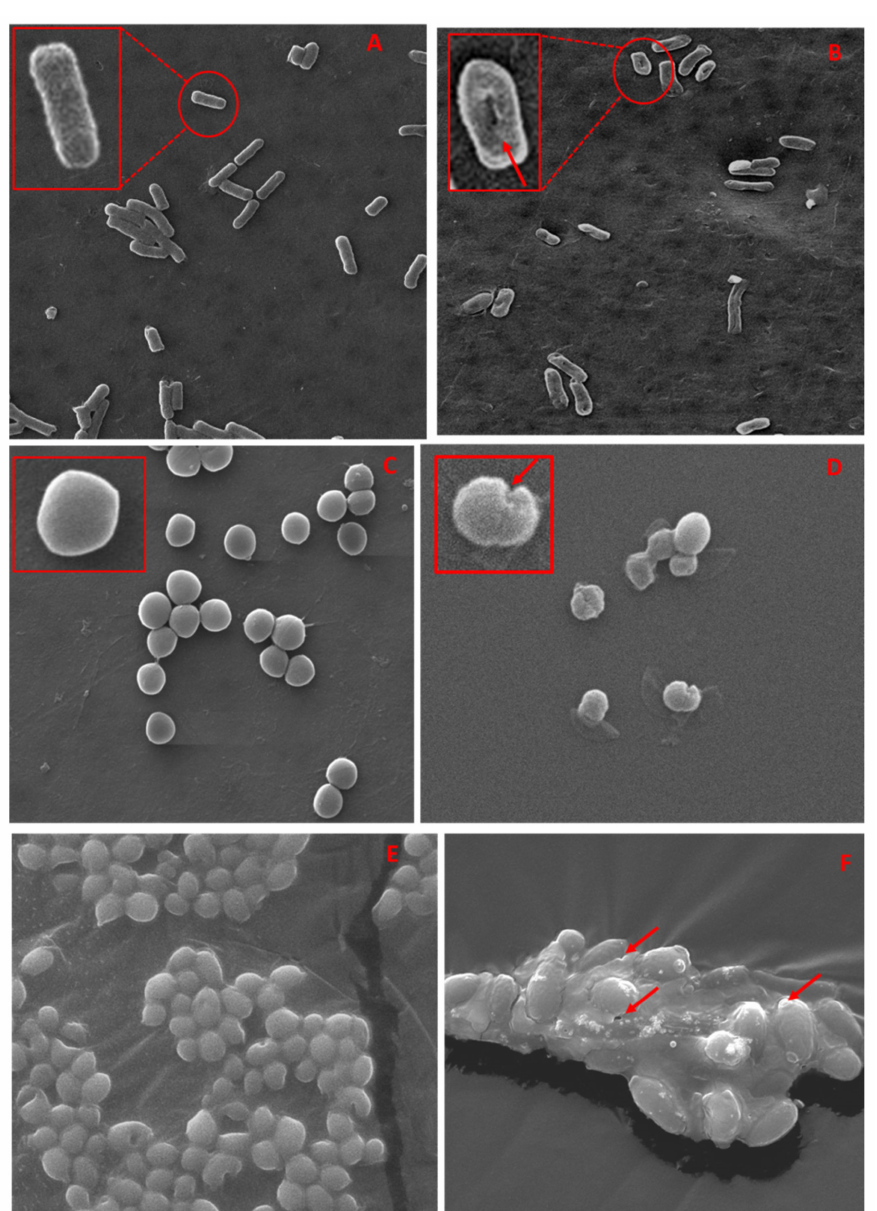
Figure 8. SEM micrographs showing morphological changes in Gram-negative multidrug resistant MDR-PA cells ( A , B ); Gram-positive methicillin resistant MRSA cells ( C , D ) and C. albicans cells ( E , F ), respectively, in the absence the ( A , C , E ) and presence ( B , D , F ) of TCE-Ag-3